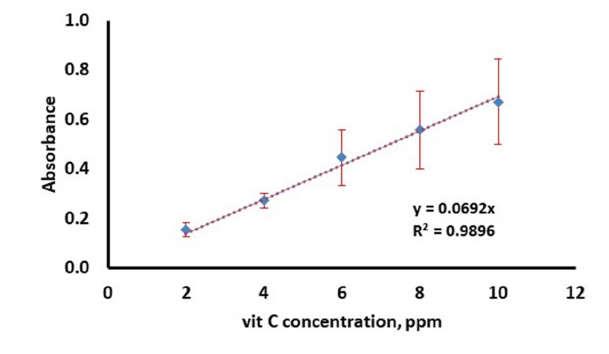
Figure 4 : Standard curve for vitamin C.